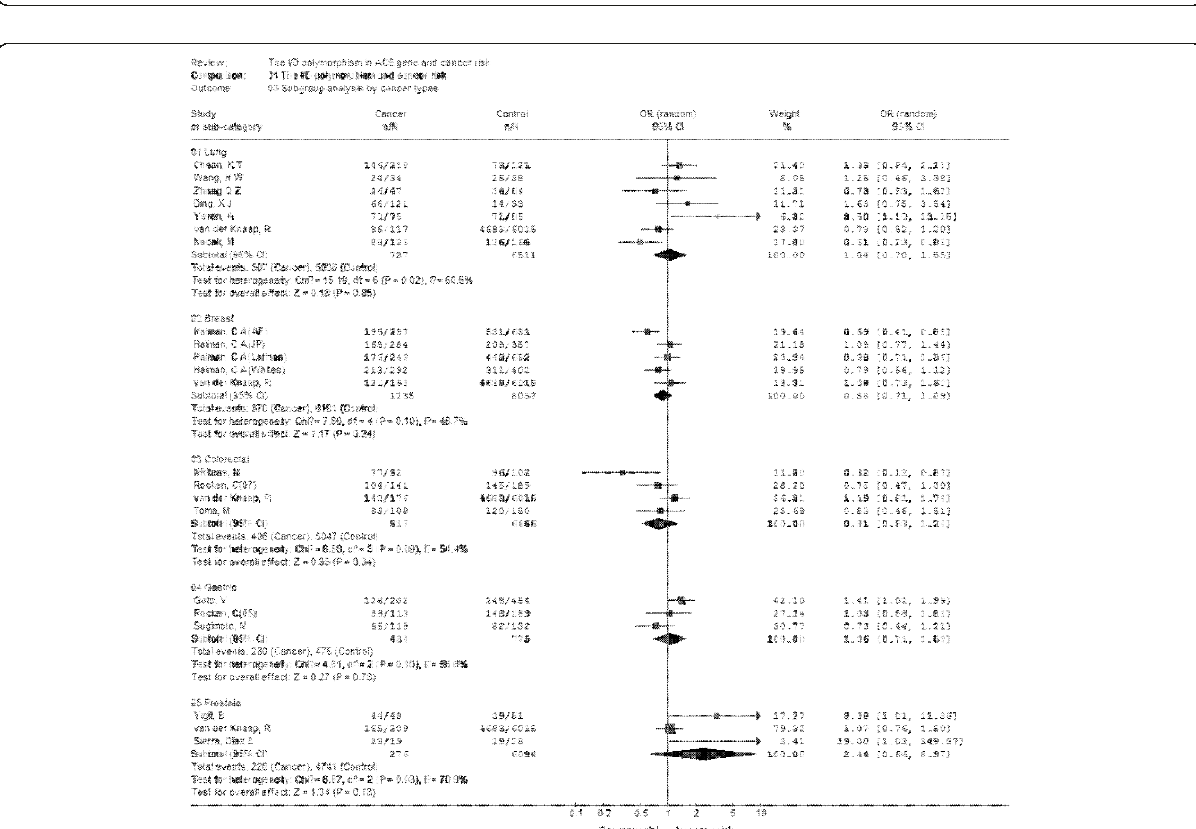
Figure 3 Meta-analysis with a random-effects model for the association between cancer risk and the ACE I/D polymorphism (DD+DI vs II): subgroup analysis by ethnicity .